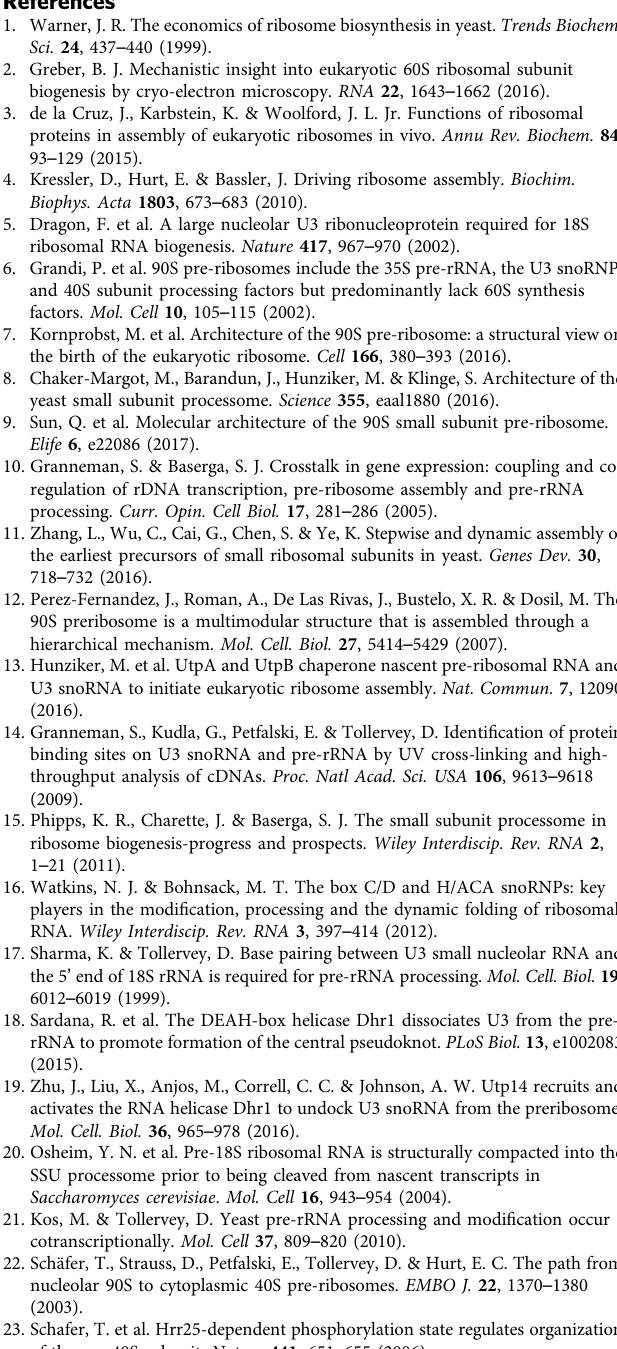
Data availability . The authors declare that the data supporting the fi ndings of this study are available within the paper and its supplementary information fi les, and available from the corresponding author upon